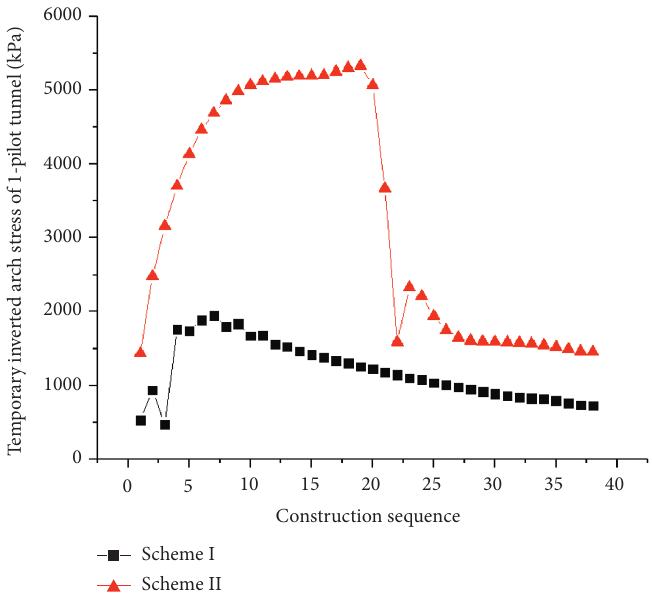
Figure 11: Time-history curve of temporary inverted arch stress of 1-pilot tunnel.